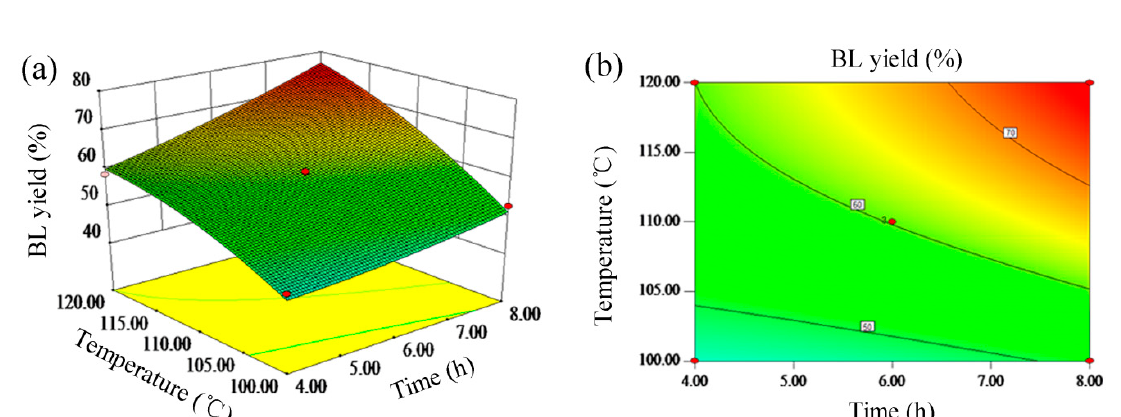
Table 3. ANVOA for the optimized RSM model.